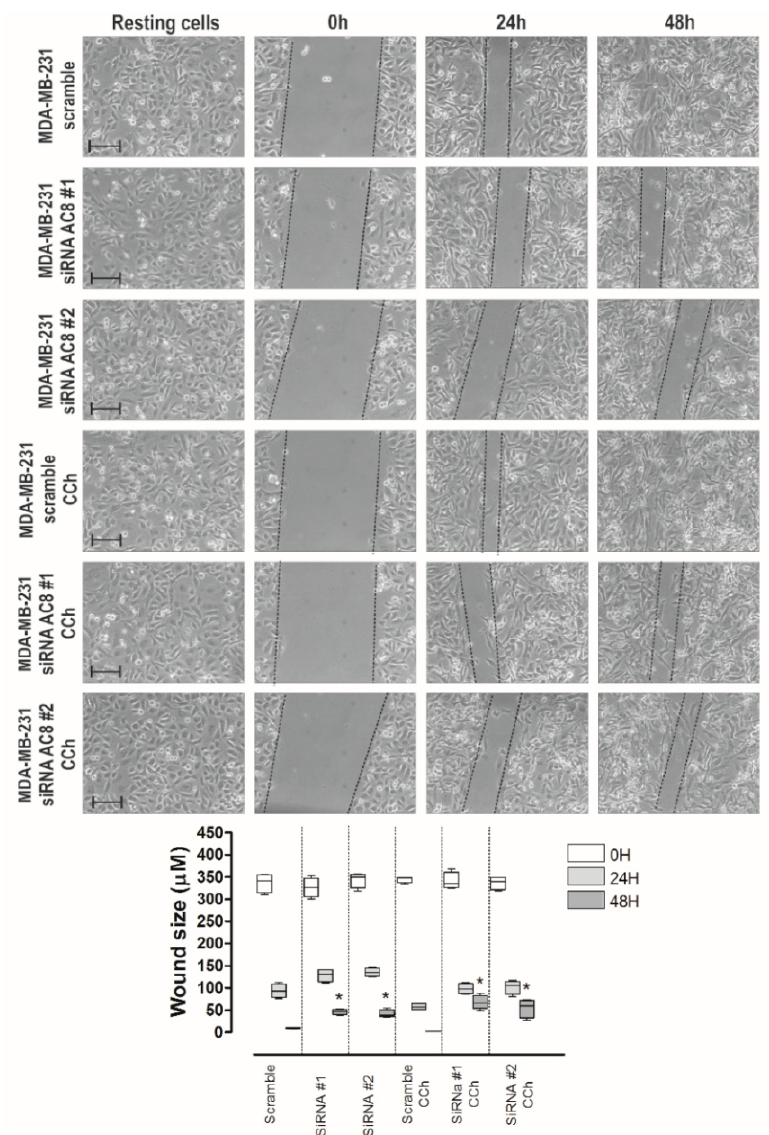
Figure 9. Role of AC8 in MDA-MB-231 cell migration. MDA-MB-231 cells were transfected with siAC8#1, siAC8#2, or scramble plasmid, as indicated. Forty-eight hours after transfection, cells were